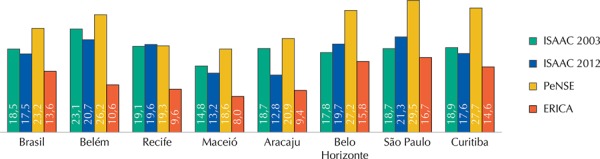
Prevalência (%) de asma ativa em adolescentes participantes do ISAAC fase III (2003-2012), PeNSE e ERICA.